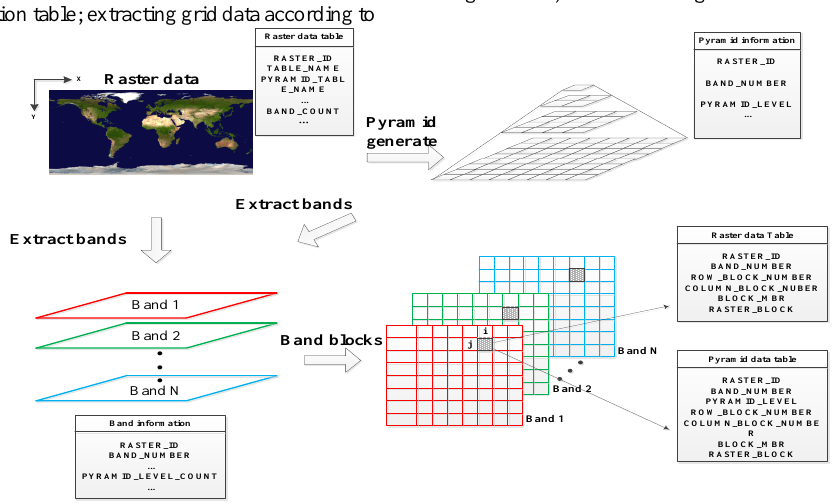
Figure 4. Generation process of raster data table structure